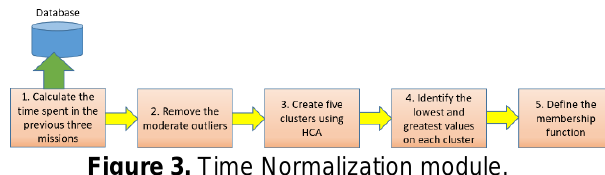
Figure 3. Time Normalization module. Figure 4 exemplifies the membership functions when c1(l) =50, c1(g) =100, c2(l) =130, c2(g) =170, c3(l) =210 and c3(g) =300.